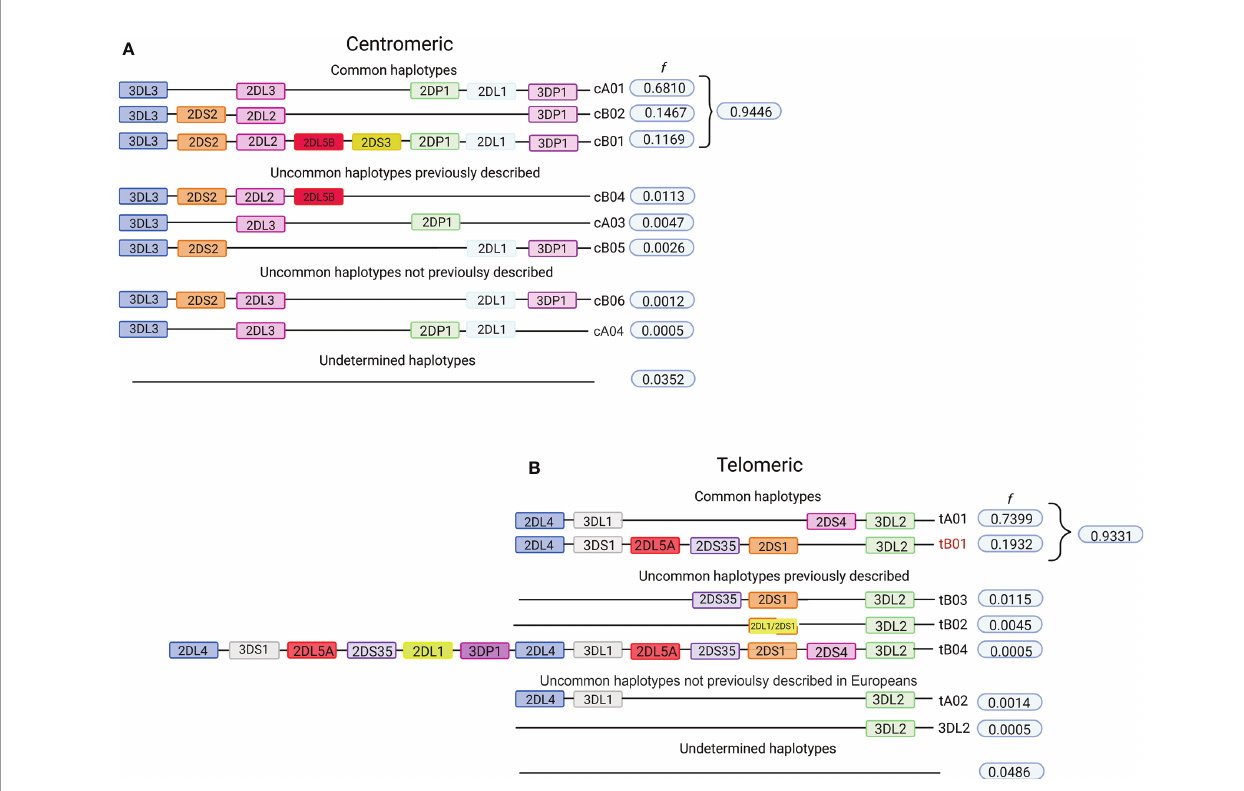
FIGURE 1 | Telomeric and centromeric gene-content haplotypes in European-Americans. Although multiple variations of the KIR full-length haplotypes have been described, most are multiple variations of a few centromeric and telomeric haplotypes. The centromeric and telomeric regions of KIR haplotypes are fl anked by the genes KIR3DL3 - KIR3DP1 and KIR2DL4 - KIR3DL2 , respectively, which are referred to as framework genes (62, 63). (A) Frequencies of centromeric KIR gene-content haplotypes in the study population. (B) Frequencies of telomeric KIR gene-content haplotypes in the study population. All listed haplotypes that were not previously described, we have observed in multiple individuals and in combination with a high frequency haplotype, allowing their inference with con fi dence. All uncommon haplotypes for which the phase could not be determined are grouped as “ undetermined ” . Figure created with